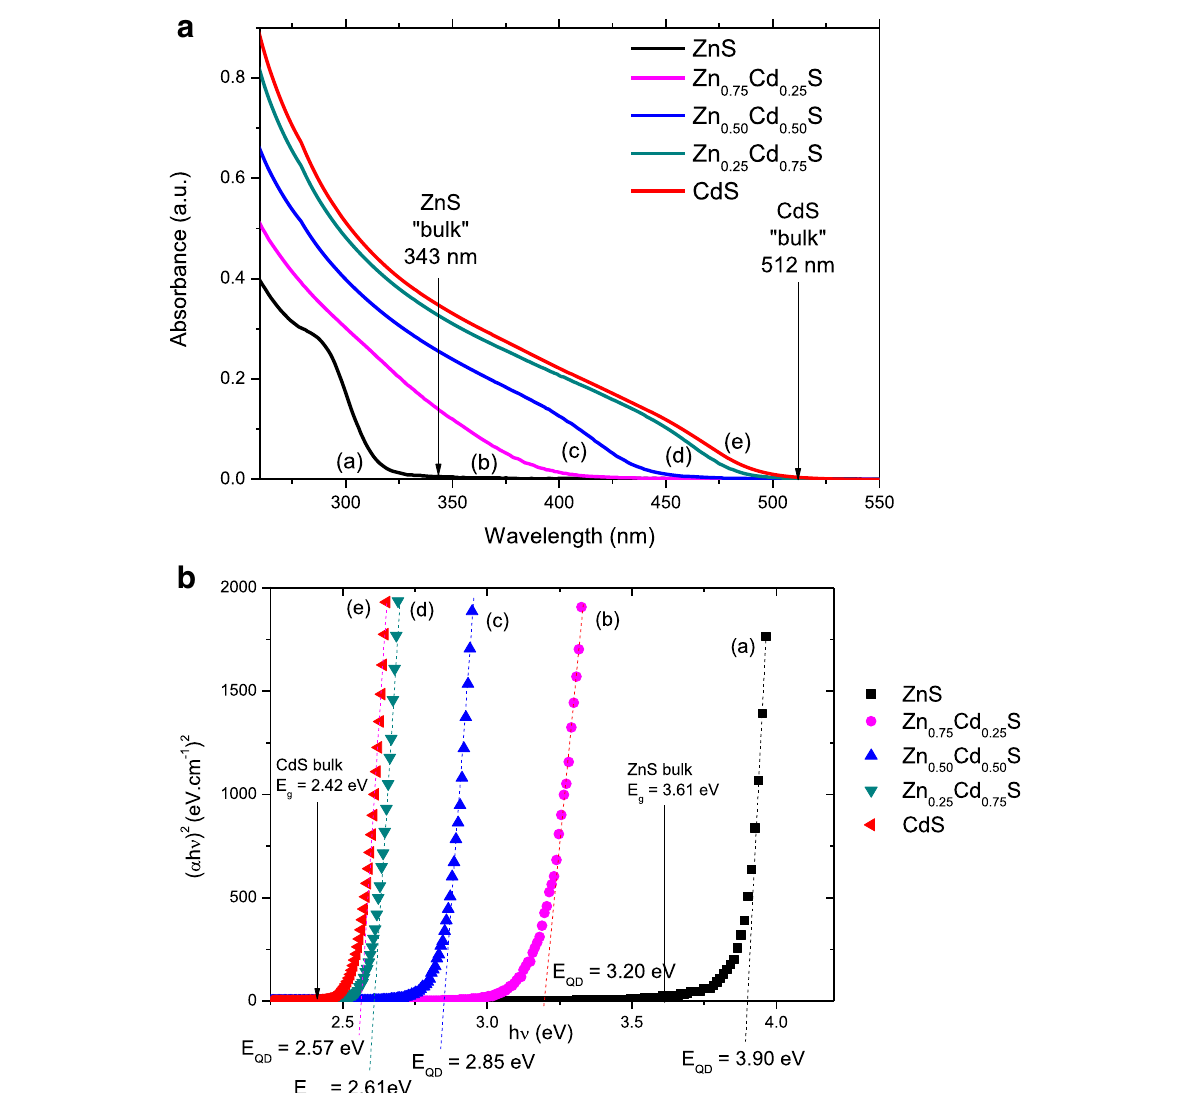
Fig. 1 UV – visible and optical absorption spectroscopy of conjugates. a UV – vis absorption spectra and b optical absorption spectra (relation) for ZnS (a) , Zn 0.75 Cd 0.25 S (b) , Zn 0.50 Cd 0.50 S (c) , Zn 0.25 Cd 0.75 S (d) , and CdS